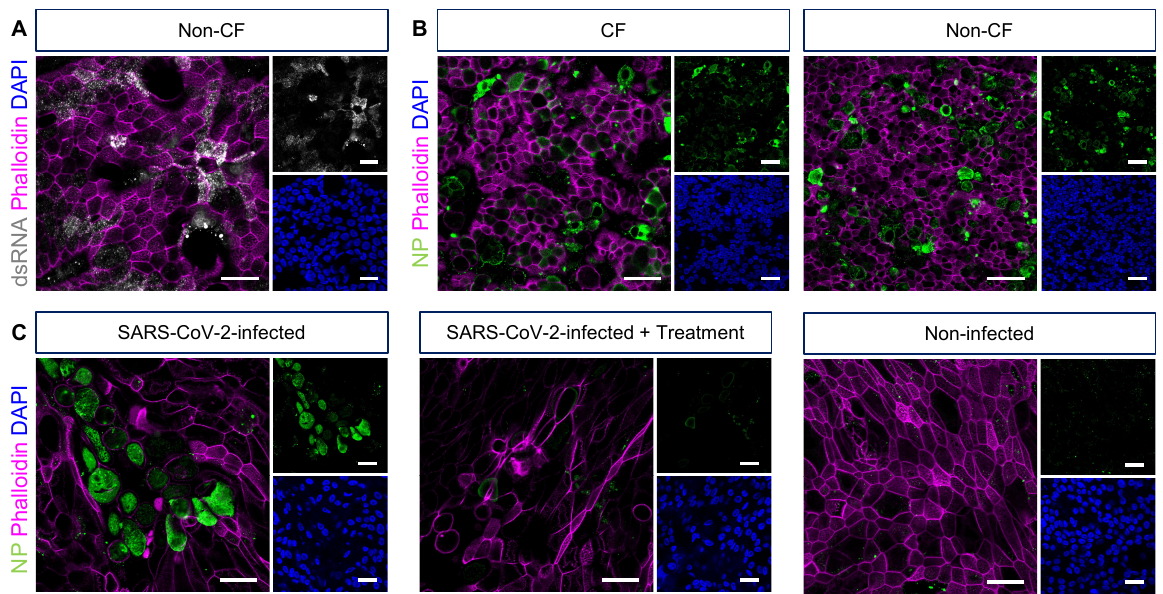
Figure 2. Visualisation of pathogen infection in airway epithelial cell air-liquid interface Figure 2. Visualization of pathogen infection in airway epithelial cell air-liquid interface cultures cultures derived from CF and non-CF participants. (A) Representative confocal images of derived from CF and non-CF participants. ( A ) Representative confocal images of double-stranded double-stranded RNA (dsRNA) in HCoV-OC43-infected air-liquid interface ( ALI) cultures. RNA (dsRNA) in HCoV-OC43-infected air-liquid interface (ALI) cultures. ( B ) Representative confocal (B) Representative confocal images of SARS nucleocapsid protein (NP) in SARS-CoV-2- images of SARS nucleocapsid protein (NP) in SARS-CoV-2-infected ALI cultures. ( C ) NP signal in infected ALI cultures. (C) NP signal in SARS-CoV-2-infected ALI cultures, with or without SARS-CoV-2-infected ALI cultures, with or without treatment with experimental compound, and in treatment with experimental compound, and in non-infected ALI cultures. 63x/1.4 objective. non-infected ALI cultures. A 63 × /1.4 objective. Scale bars: 20 µ m. Scale bars: 20 µm.